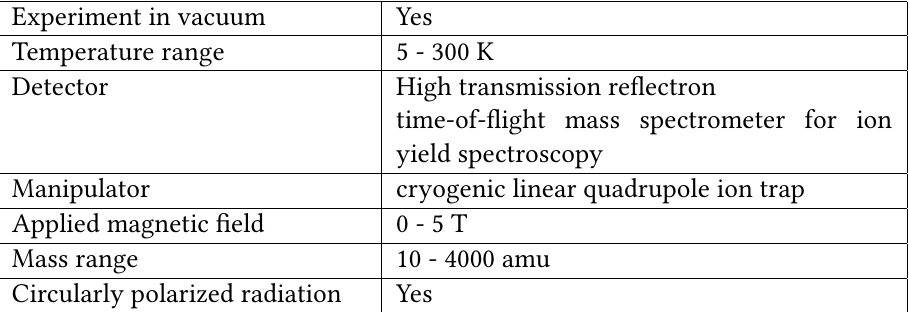
Table 1: Technical parameters of the Nanocluster Trap